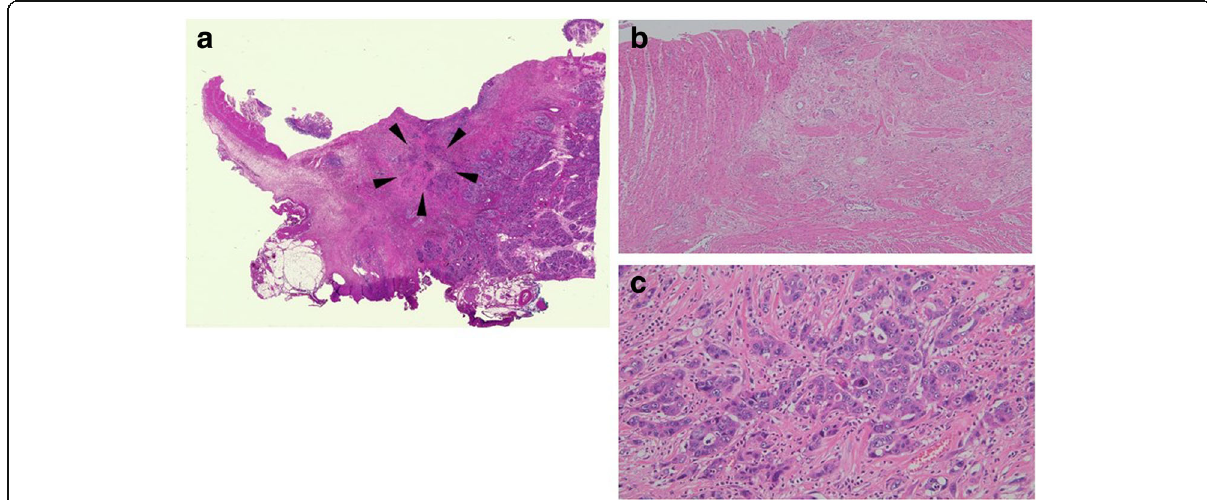
Fig. 5 Microscopic findings of the resected specimen. a Most of the primary tumor had been replaced by fibrosis, and only a few cancer cells (arrow head) were seen in the central area of the tumor (HE, × 4). b The wall structure of the duodenum had also been destroyed and replaced with fibrosis, but there were no cancer cells (HE, × 40). c Degenerated cancer cells were visible in the central area of the tumor (EVANS grade IIB, HE,×